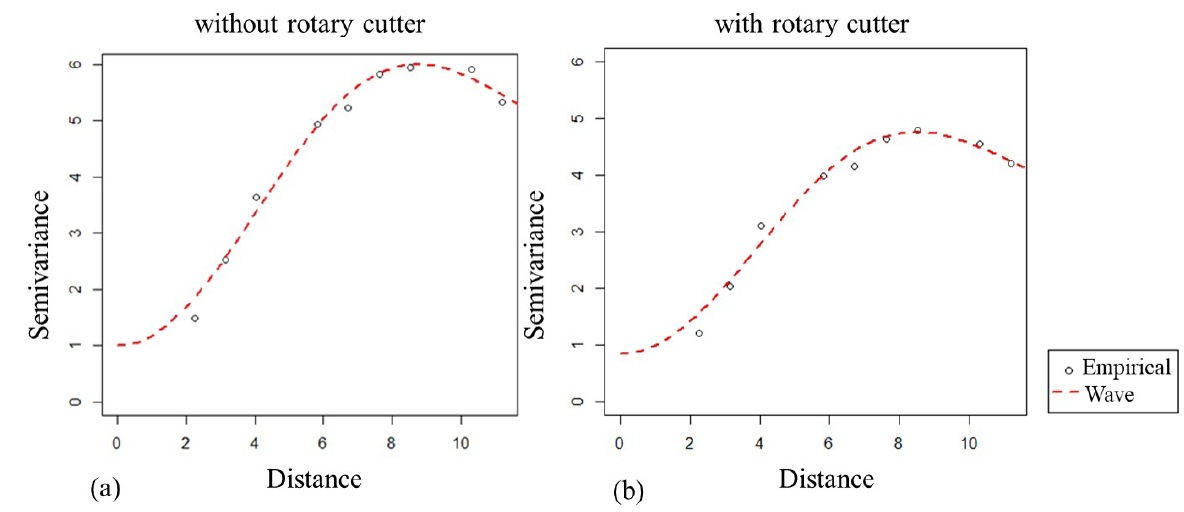
Figure 2. Semivariogram of the noise emitted by the agricultural tractor (a) without by a tractor activation of a rotary cutter (b) with by a tractor activation of a rotary